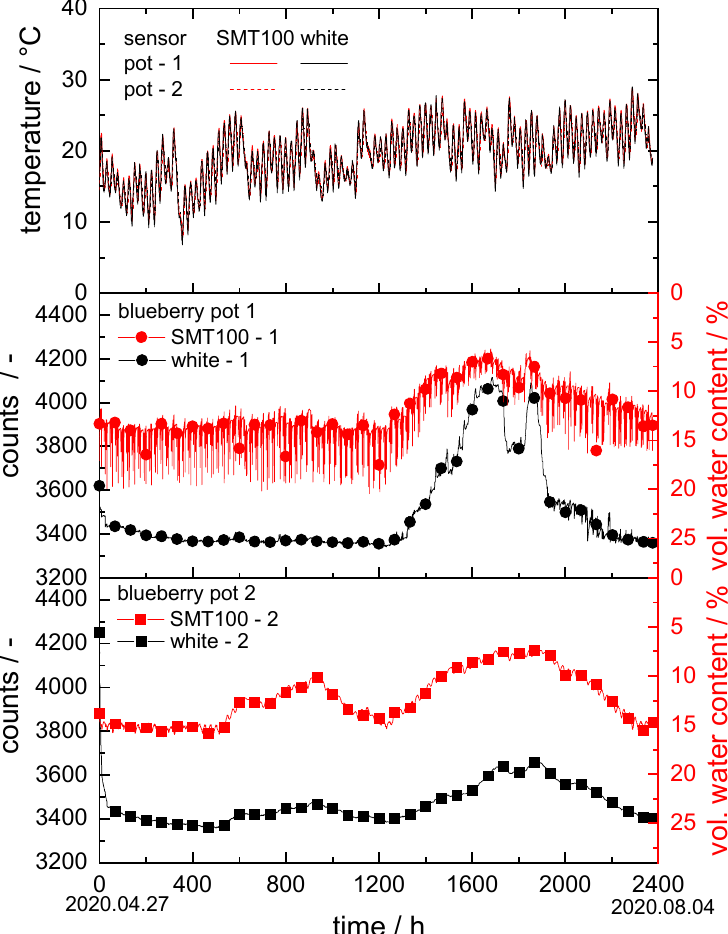
Figure 5. Soil moisture measurement experiment at Erlenhof in two blueberry pots: the upper graph shows temperature vs. time at all sensor positions; in the middle and lower graphs, counts are plotted vs. time in hours for our new sensors; vol. water content vs. time for the SMT100. The data collected in the second blueberry pot were similar to those from the first